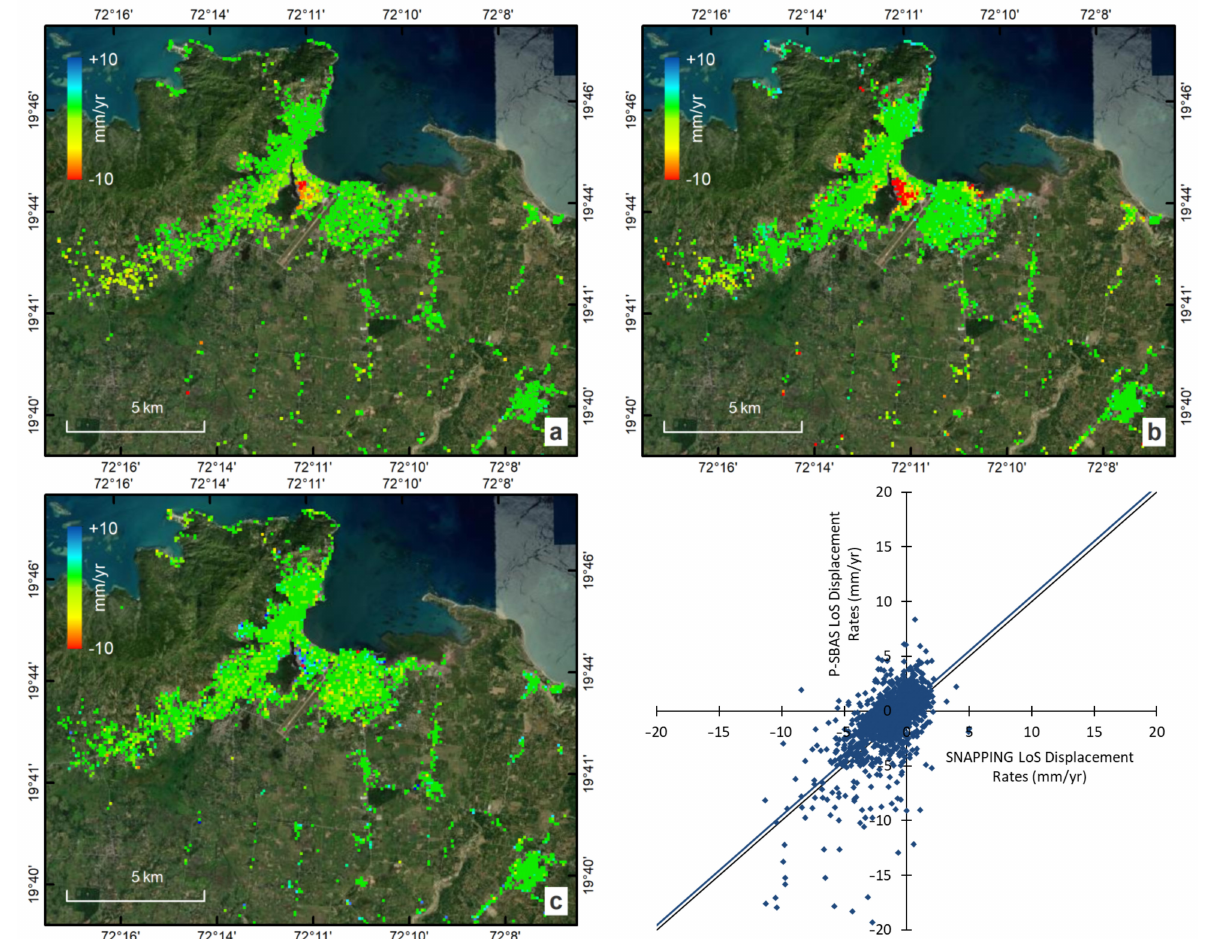
Figure 7. Sentinel-1 LoS displacement rates over Cap-Haitien (Haiti) for the period 2017–2019 based on ( a ) SNAPPING PSI Med and ( b ) P-SBAS services. Differences between the solutions (SNAPPING minus P-SBAS) are spatially shown ( c ), and the dispersion of the calculated motion rates is also plotted. The majority of differences are within the error estimates of the technique. Note that only neighboring points (100 m radius) between the independent solutions are shown. The original measurements, as well as the additional points detected by each service, are shown in the supplementary material (Figure